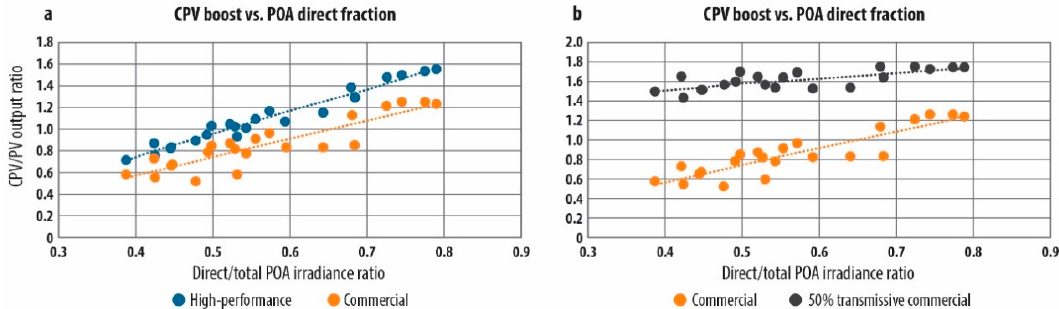
Figure 3. ( a ) Increase in annual solar resource utilization for two modeled tracking-integrated CPV modules: “commercial” module based on Insolight’s THEIA technology [28,29] and “high-performance” module based on prototype of Price et al. [26,27]. “CPV boost” is ratio of annual energy outputs of CPV and reference modeled PV array (17% efficiency). “POA direct fraction” is ratio of annual plane-of-array beam irradiance to total POA irradiance. Data correspond to Table 1. ( b ) CPV boost vs. direct fraction for the “commercial” non-transparent model and the same with 50% transparency to unconcentrated light. Table 1. Summary of comparative performance simulations of TI-CPV and PV systems mounted at latitude tilt at 22 global locations, based on TMY weather files from the National Solar Resource Database. Both high and low DNI locations are included as indicated in the “direct fraction” column; direct fraction is the ratio of the annual beam POA irradiance to the total POA irradiance. The CPV boost is the ratio of the simulated annual CPV output to that of the reference silicon PV system. While the “commercial” CPV model provides only a modest boost in high DNI conditions, the semi-transparent CPV model offers a consistent boost of 50–75% across nearly all locations.